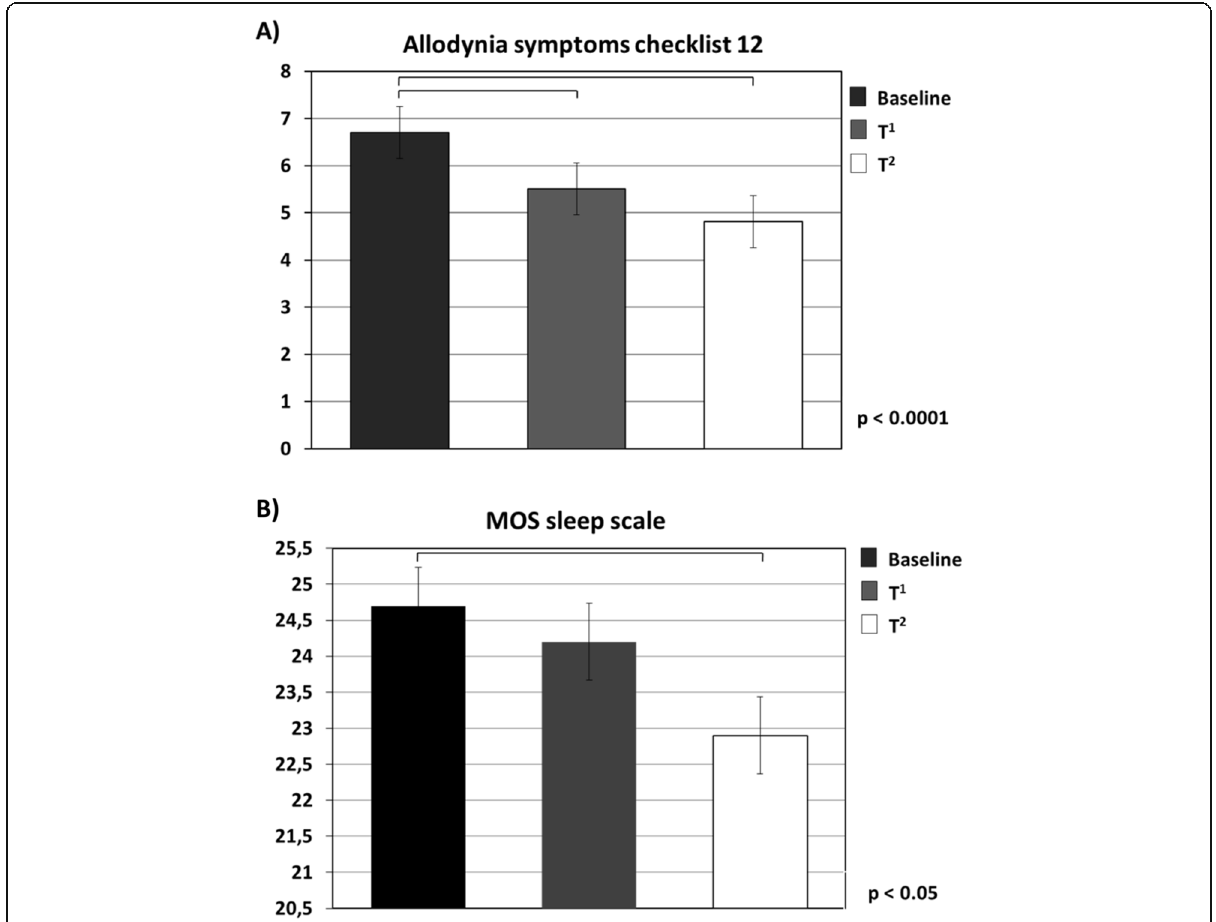
Fig. 5 Allodynia Symptom Checklist-12 (ASC-12) scores and Medical Outcomes Study (MOS) sleep scale scores at baseline (T 0 ), and at the end of the third (T 1 ) and of the sixth month (T 2 ) of erenumab